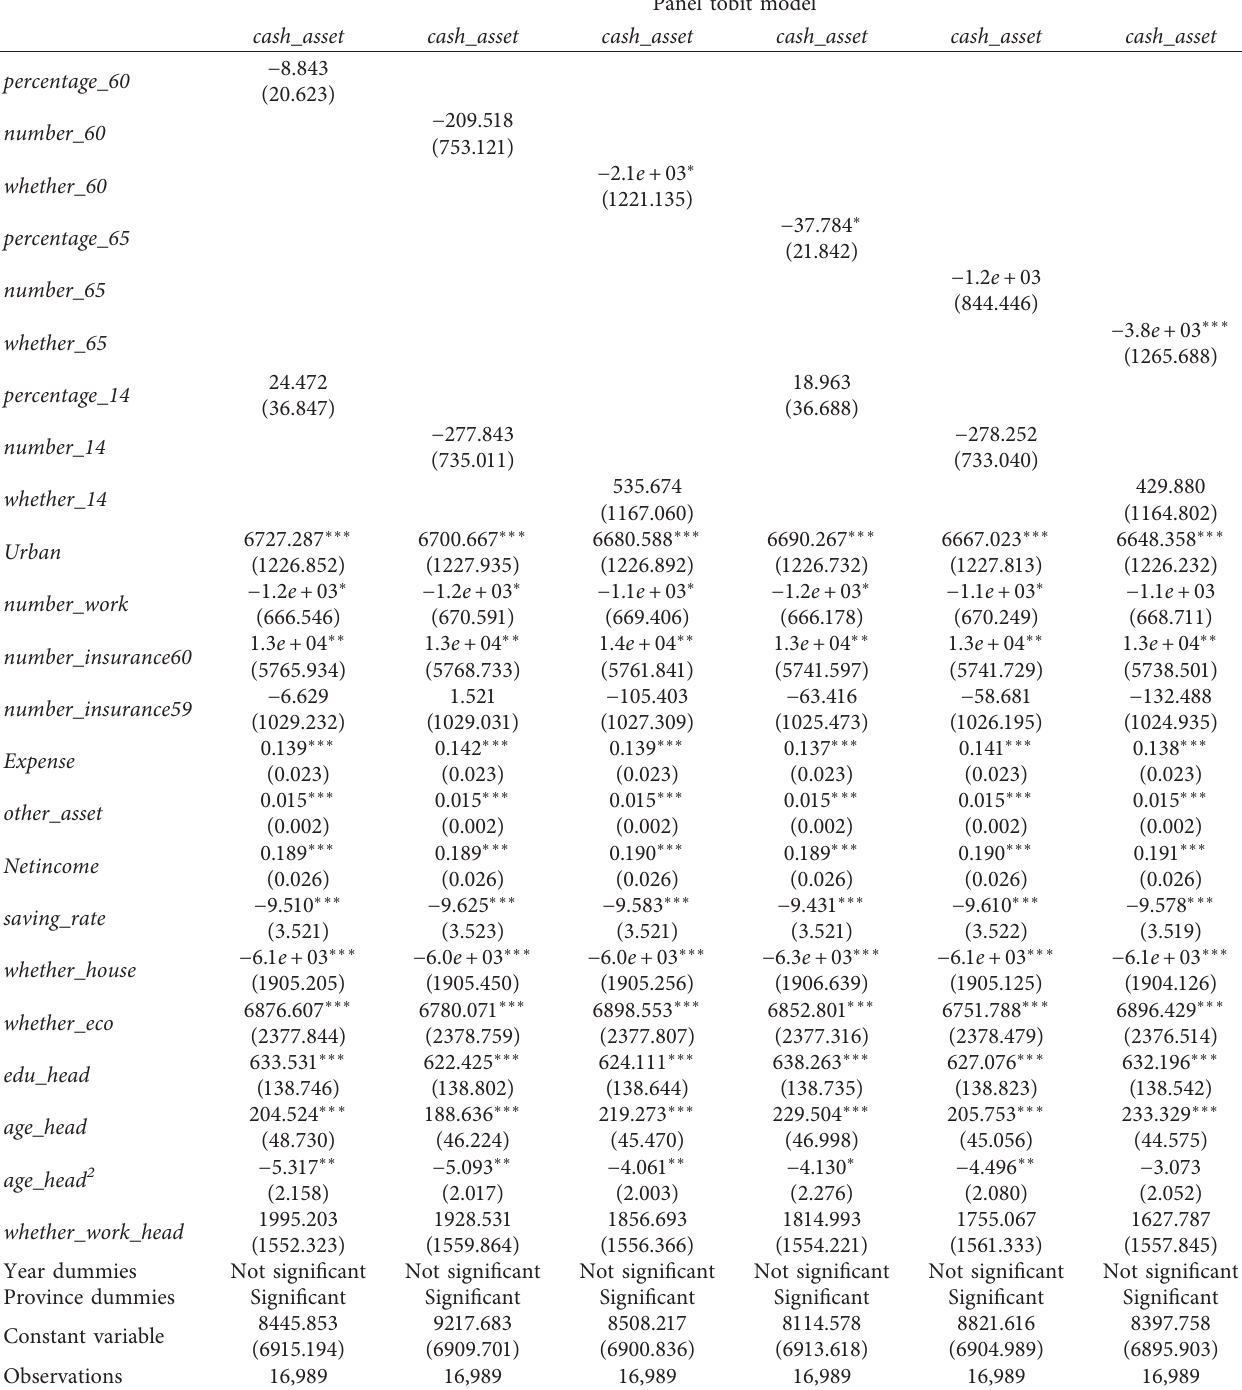
Table 4: Results on the scale of families’ cash and deposits. Panel tobit